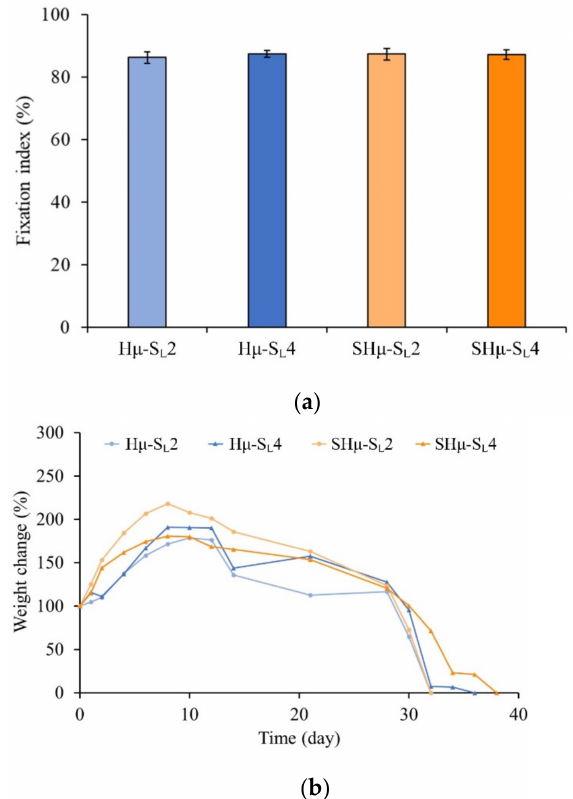
Figure 5. ( a ) Amine group fixation rate of different hydrogel scaffolds after cross-linking ( n = 18) and ( b ) weight change of different hydrogel scaffolds after immersion in deionized distilled water (ddH 2 O) ( n =